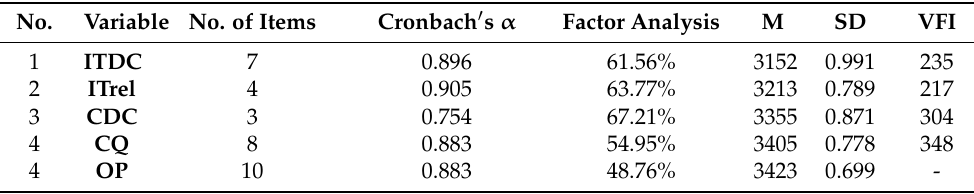
Table 2. Variables